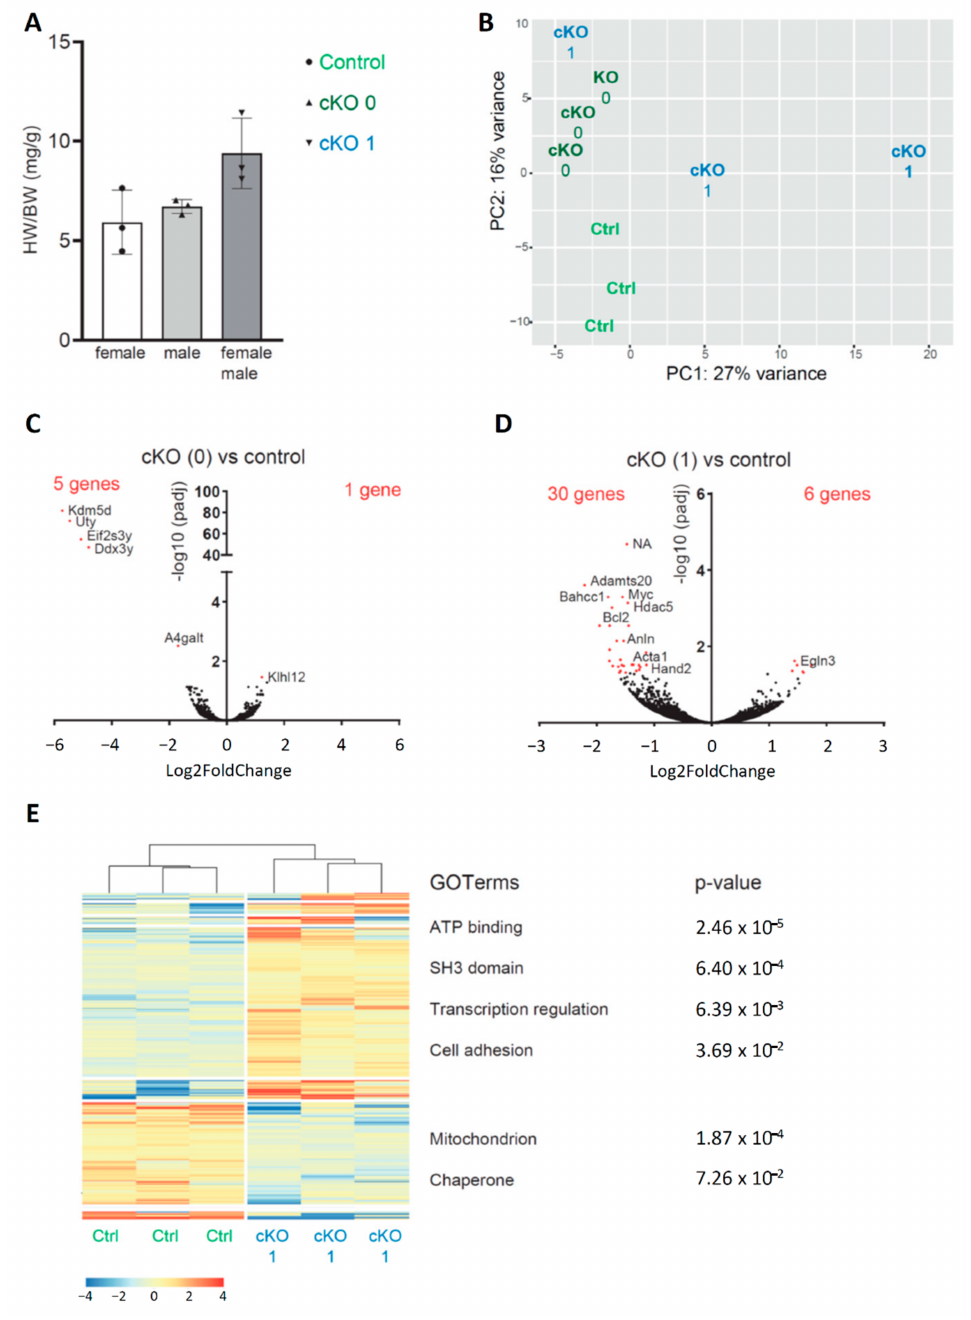
Figure 4. ( A ) Heart-weight-to-body-weight ratio (HW/BW) of mice used for sequencing (control: n = 3, cKO: n = 5). cKO mice with a HW/BW < 8 mg/g received a stress score of 0. cKO mice with HW/BW > 8 mg/g received a stress score of 1. ( B ) Principal component analysis shows clustering of the control samples and samples with a score of 0. Control samples and samples with different HW/BW scores are marked by different colors. ( C ) Volcano plot shows differential gene expression between control and cKO mice with a score of 0. Significantly differentially expressed genes ( p - adjusted for multiple testing, false discovery rate < 0.05) are marked in red. ( D ) Volcano plot shows differential gene expression between samples of control and cKO with a score of 1. Significantly differentially expressed genes ( p -adjusted for multiple testing, false discovery rate < 0.05) are marked in red. ( E ) Functional annotation heat map based on hierarchical clustering on the most differential expressed genes between control and cKO score = 1 ( p -value < 0.05) and GO terms of groups of differentially expressed genes. The p -value of GO terms is corrected for multiple testing